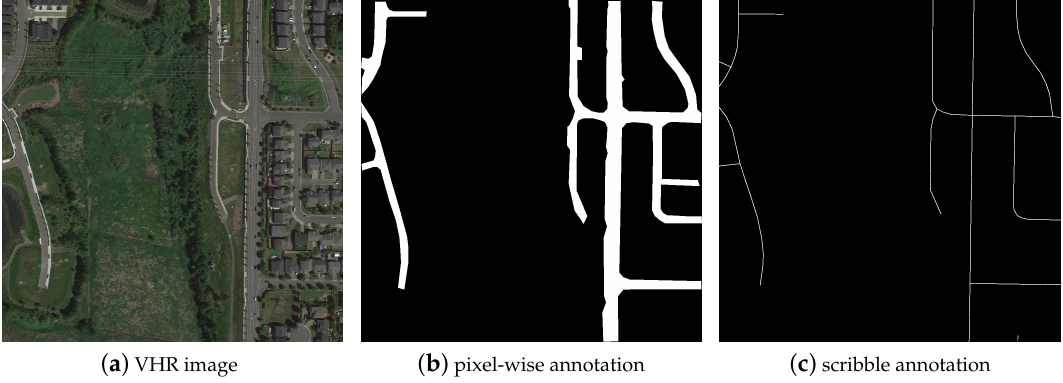
Figure 1. Sample of Very High Resolution (VHR) images used in the experiments. ( a ) The VHR image, ( b ) the corresponding pixel-wise annotation, and ( c ) sparse scribble of the OpenStreetMap (OSM)